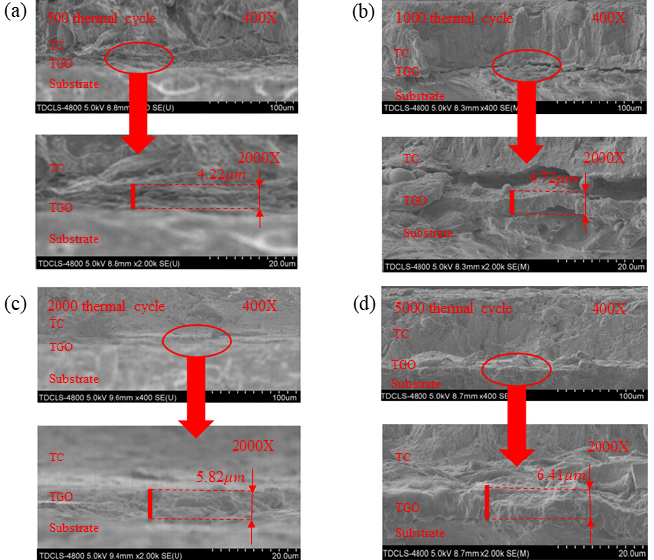
Figure 8. ( a ) The SEM results of the sample after 500 thermal cycles; ( b ) after 1000 thermal cycles; ( c ) after 2000 thermal cycles; ( d ) after 5000 thermal cycles.